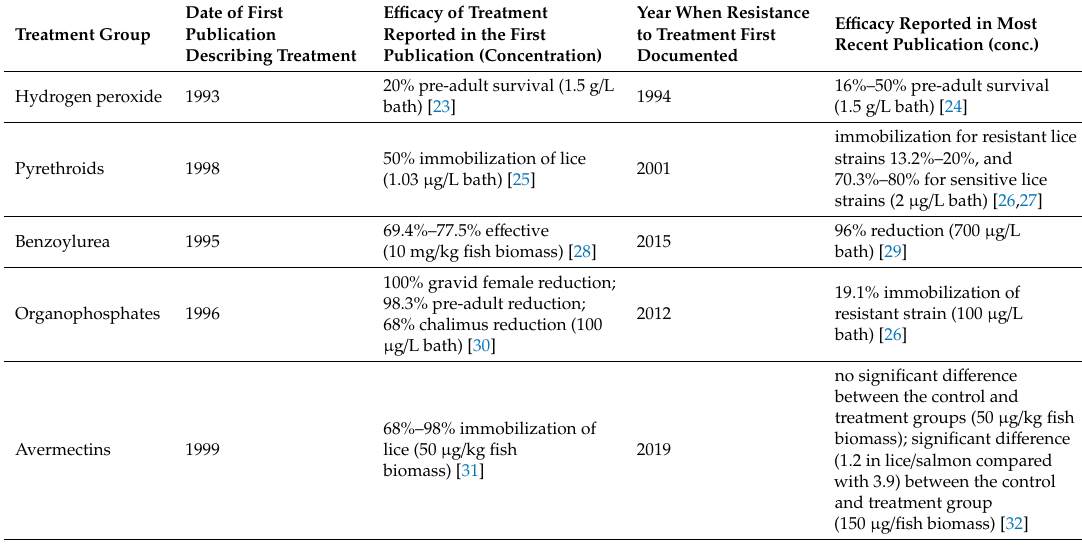
Table 2. E ffi cacy of chemical treatments in relation to time since their